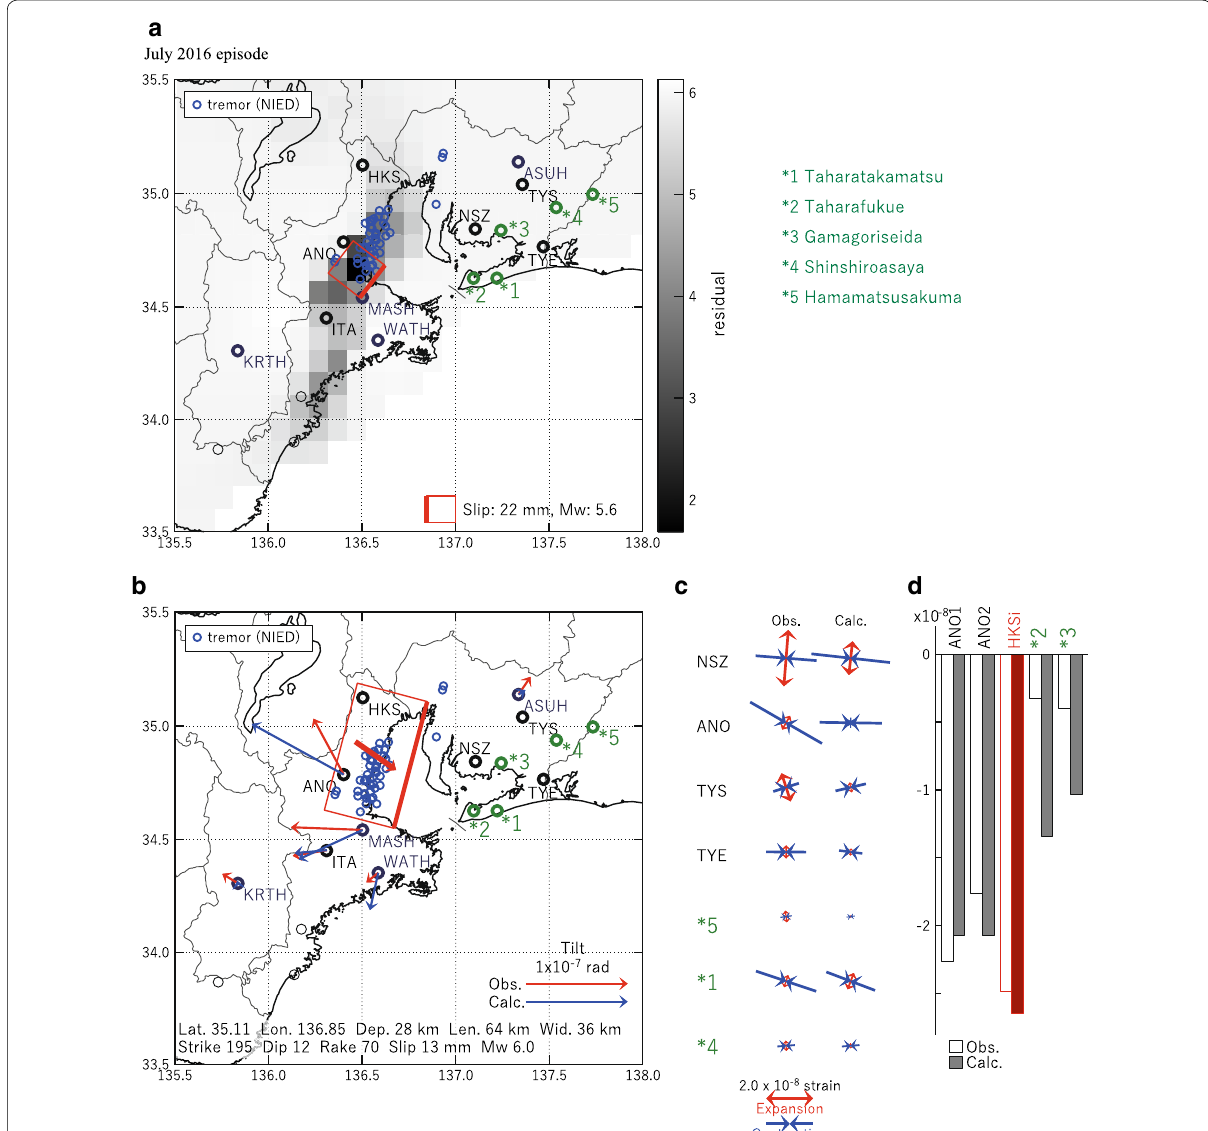
Fig. 6 Estimated fault model of the short-term SSE in July 2016. Black, dark blue, and green circles indicate AIST, NIED Hi-net, and JMA observation sites, respectively. Small blue circles indicate hypocenters of deep low-frequency tremor estimated by NIED. a The initial fault model estimate. The fault plane was fixed as 20 km 20 km, and the slip amount on each fault patch was estimated by minimizing the sum of residuals after × comparison with the observed strain, tilt and groundwater pressure distribution. The gray color scale shows the distribution of the residuals, and the red rectangle indicates the portion of the fault with the lowest residual. b The refined fault model. The red rectangle shows the length and width of the estimated fault model. Observed and calculated tilt changes are shown by red and blue arrows, respectively. c Observed and calculated principal strain changes. d Observed and calculated volumetric strain changes. At ANO1, ANO2, and HKSi, observed groundwater pressure changes were converted to volumetric strain changes. At Taharafukue and Gamagoriseida, volumetric strain changes were directly